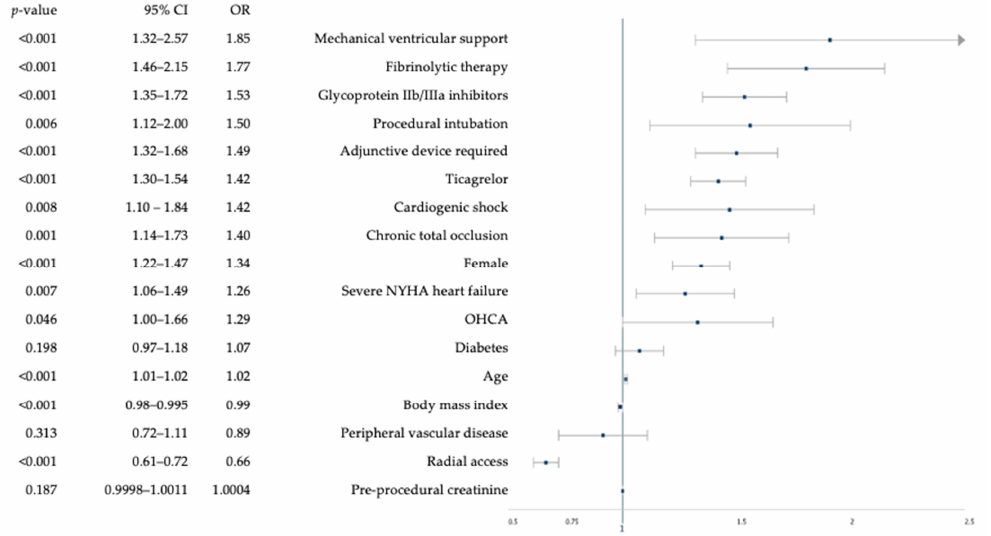
Figure 2. Independent predictors of BARC bleeding. BARC = bleeding academic research consortium, CI = confidence interval, NYHA = New York health association, OHCA = out-of-hospital cardiac arrest, OR = odds ratio.